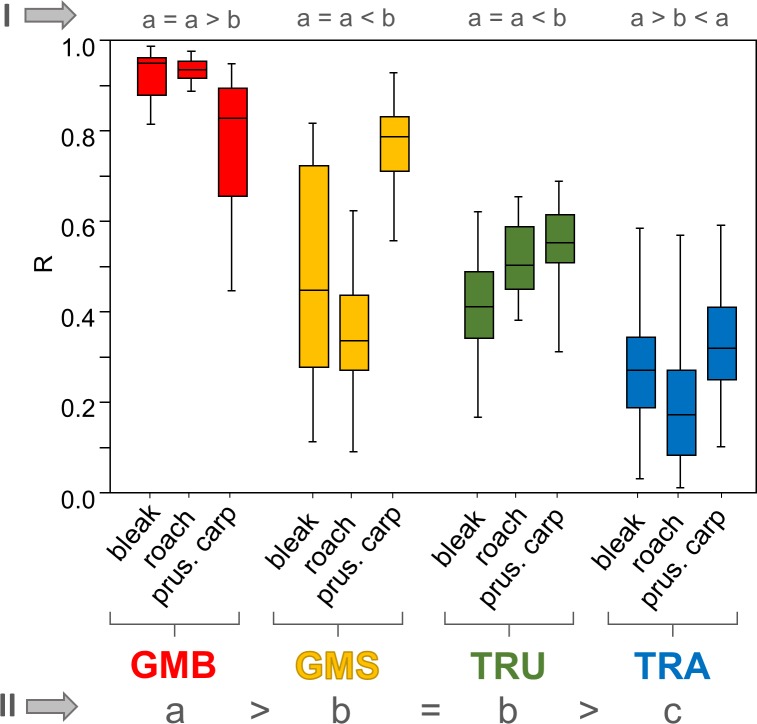
Boxplots of reproducibility derived from pairwise Mantel tests of inter-measurer R values (for data see S6 Table).Each box presents 81 pairwise R values obtained from a comparison of datasets derived from the same subjects by different measurers. The box represents the 25% and 75% quartiles, with the line in the box representing the median. The whiskers show the highest and lowest values within the dataset. In rows indicated by grey Roman numerals, datasets were analysed at different levels, i.e. I (species; n = 81) and II (method; n = 243). Groups with the same letter did not differ significantly (p < 0.05) using the Kruskal-Wallis test. Color codes corresponds with Figs 1 and 2.